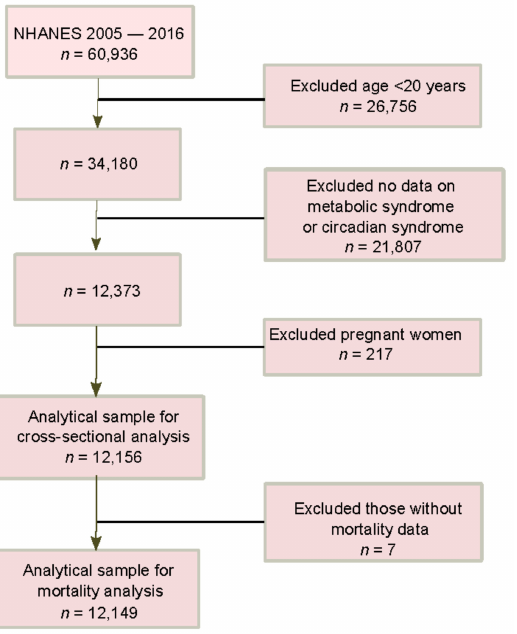
Figure 1. Sample flow chart. Abbreviations: NHANES, National Health and Nutrition Examination Survey.